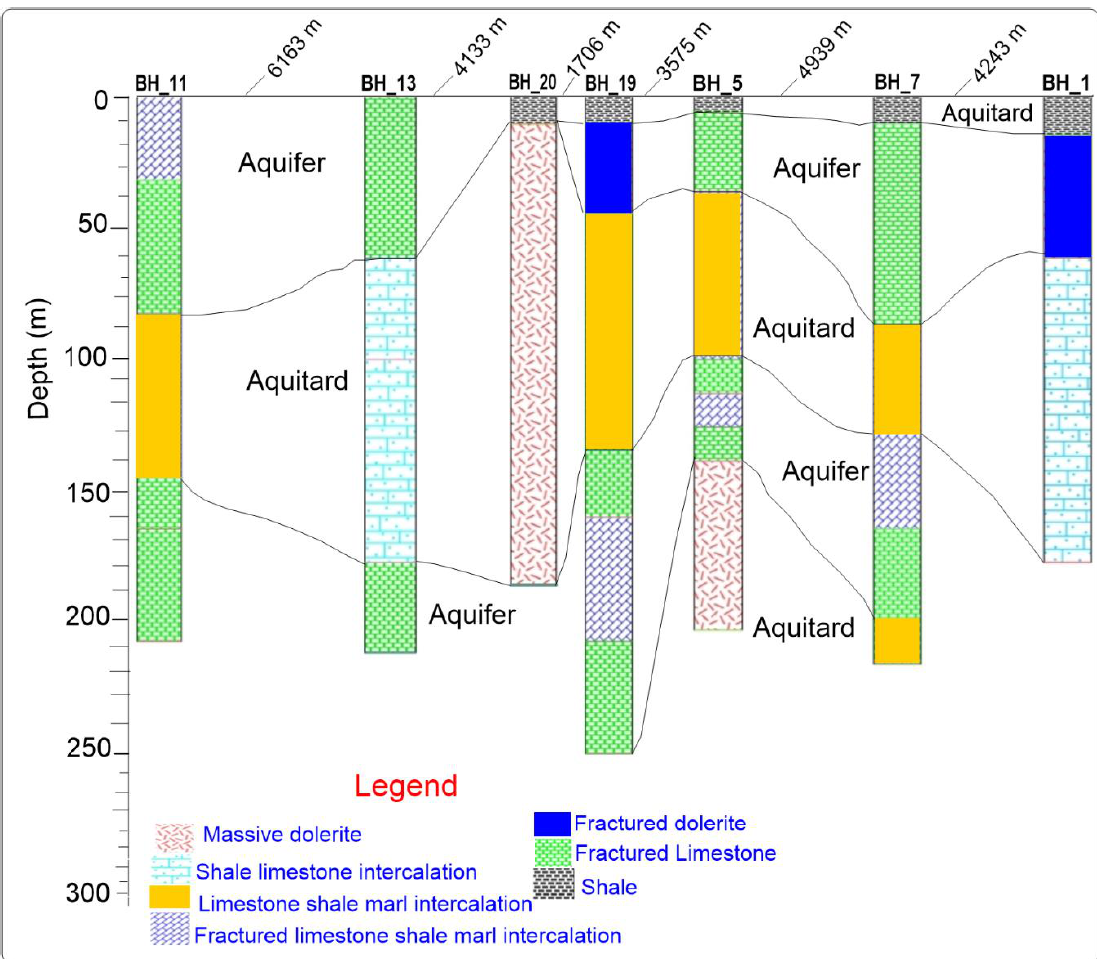
Figure 3. Hydrogeological cross-section in the study area along A1 to A2, as shown in Figure